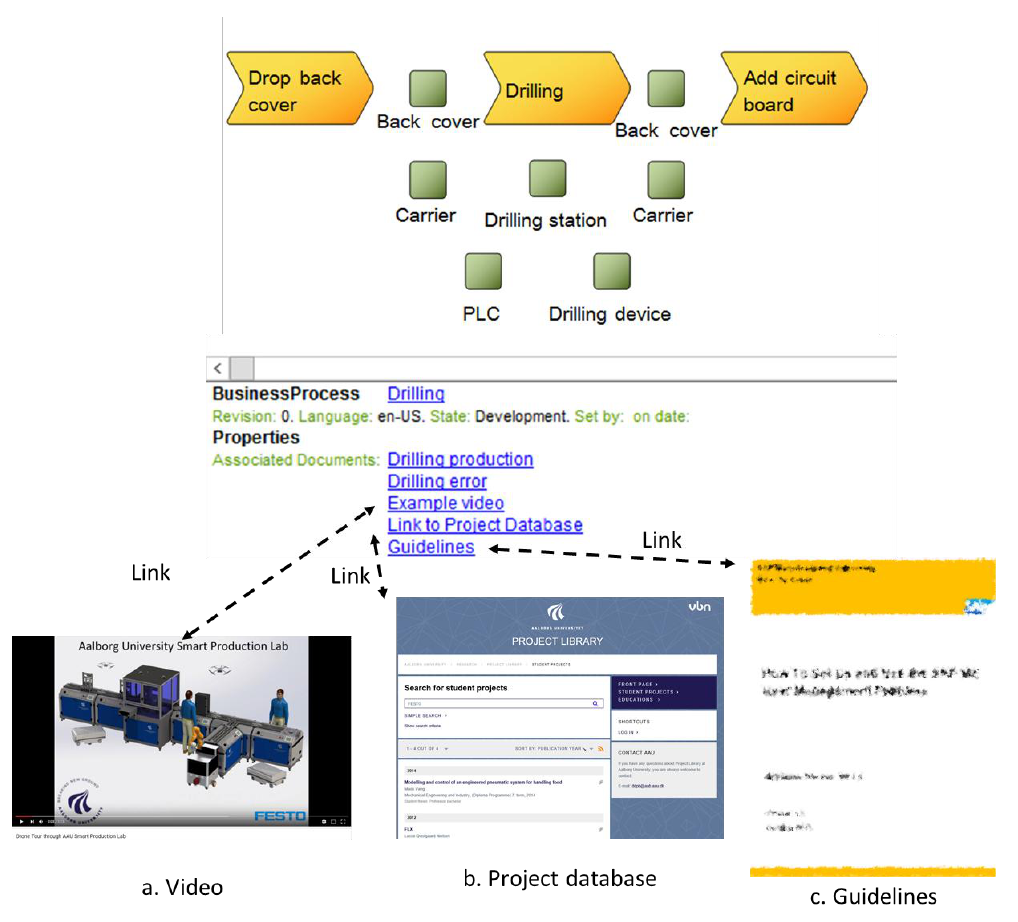
Figure 14. External resources linked to the